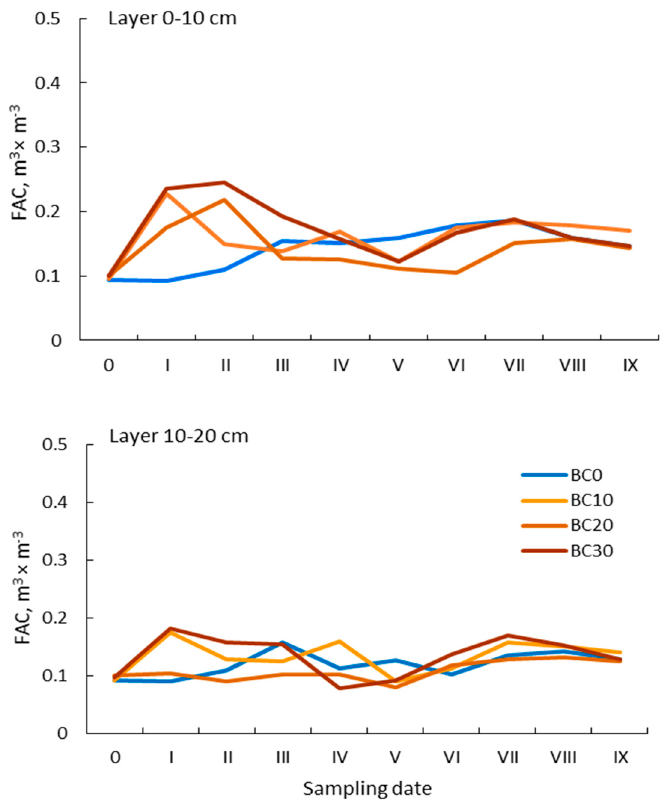
Figure 4. Air capacity at the potential − 15.5 kPa (FAC). Explanations as for Figure 1.